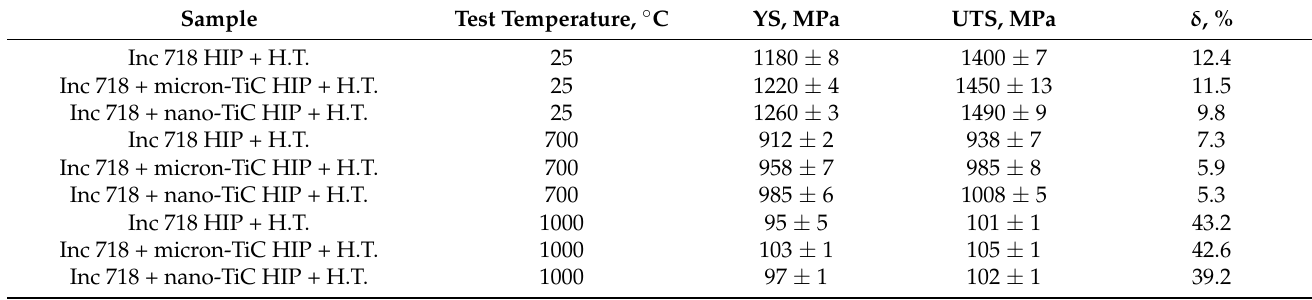
Table 7. Mechanical properties of post-processed SLM samples at different